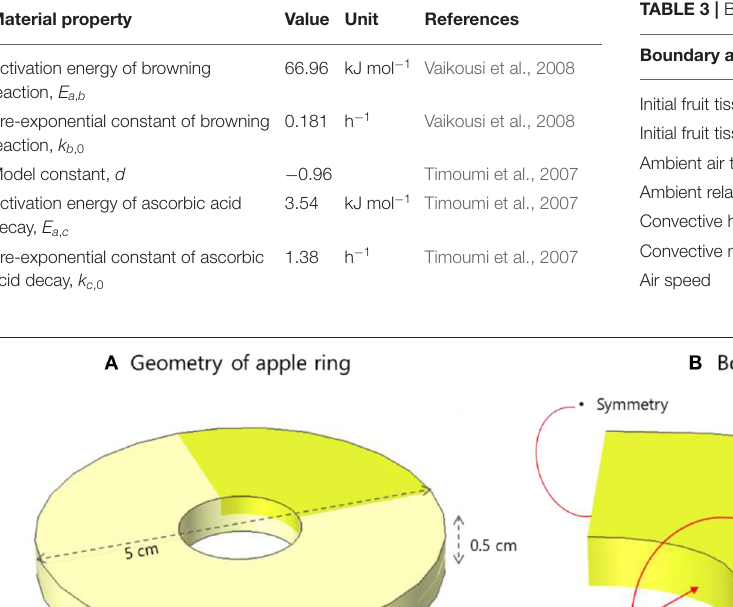
TABLE 2 | Model parameters for the quality model.